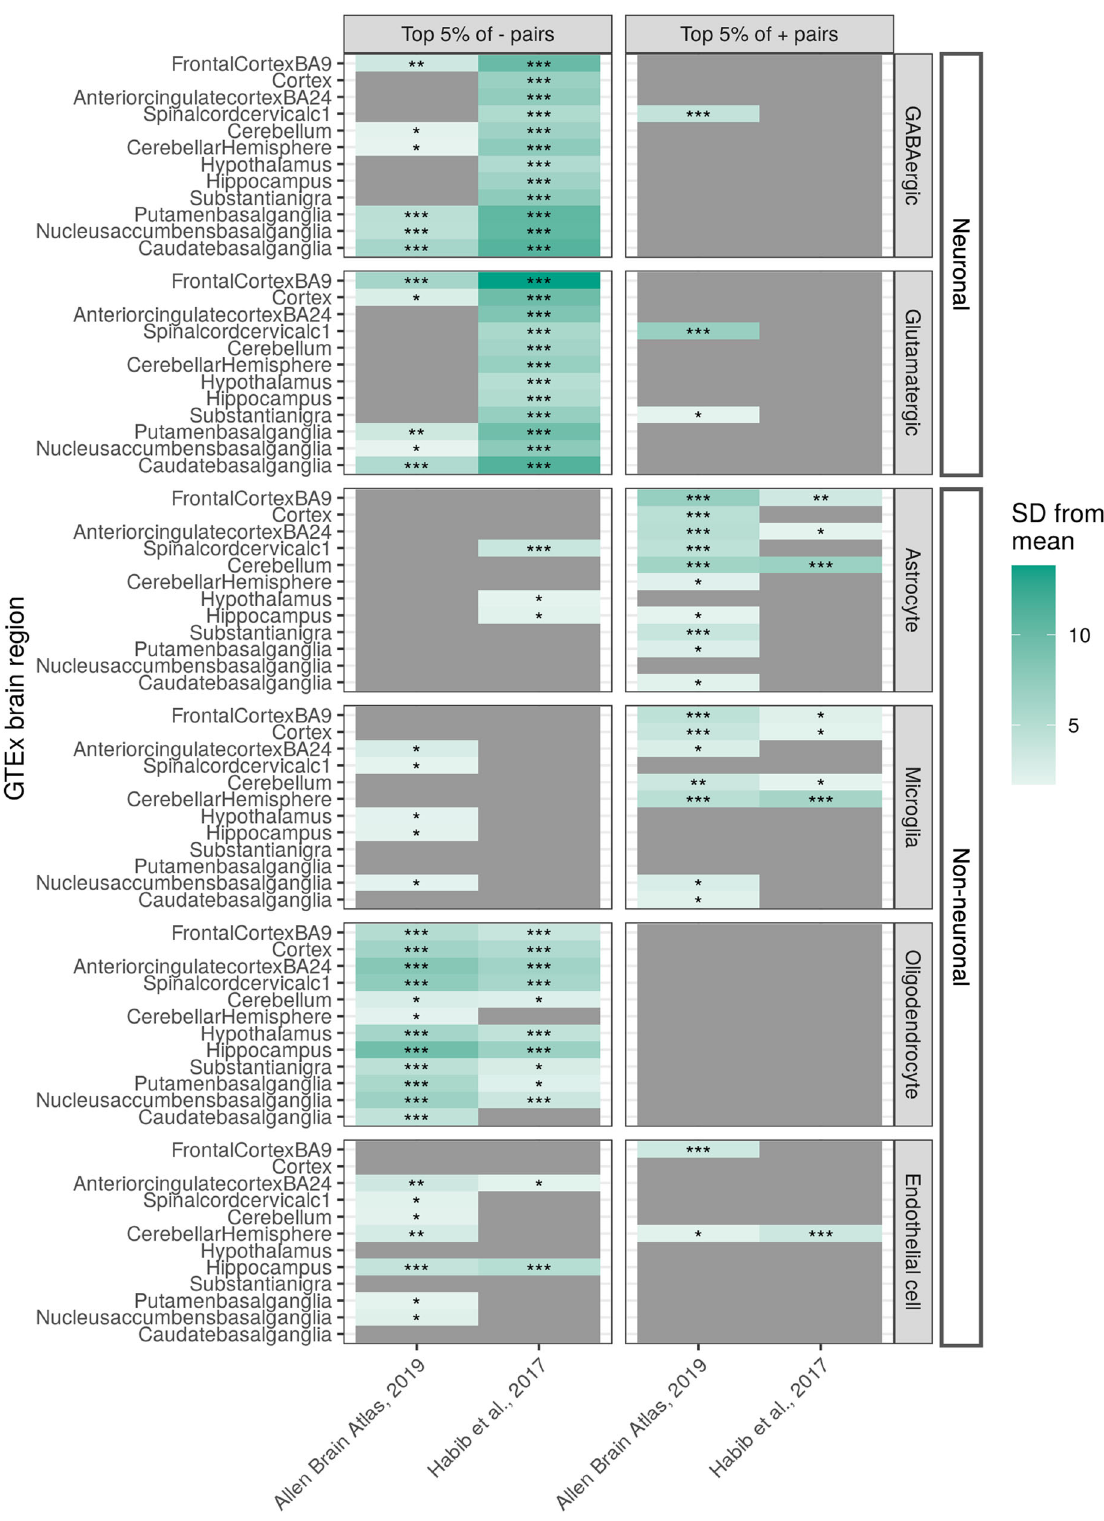
Fig. 2 EWCE-derived cell-type enrichments for 12 GTEx CNS regions. The left-hand y axis refers to the GTEx CNS region, while the right-hand facet labelling refers to the cell-type. For each cell-type in each region, the metric for enrichment is shown as the number of standard deviations from the bootstrapped mean (SD from mean, indicated by the colour bar). A dark green colour indicates a higher number of standard deviations from the mean, while lighter green indicates fewer standard deviations from the mean. The x axis indicates which scRNA-seq dataset the underlying cell-type speci fi city matrix was derived from. For each association, the following asterisks are overlaid to indicate the multiple test correction threshold passed: *0.05/ 12 < P < 0.05; **0.05/12*6 < P < 0.05/12; *** P <